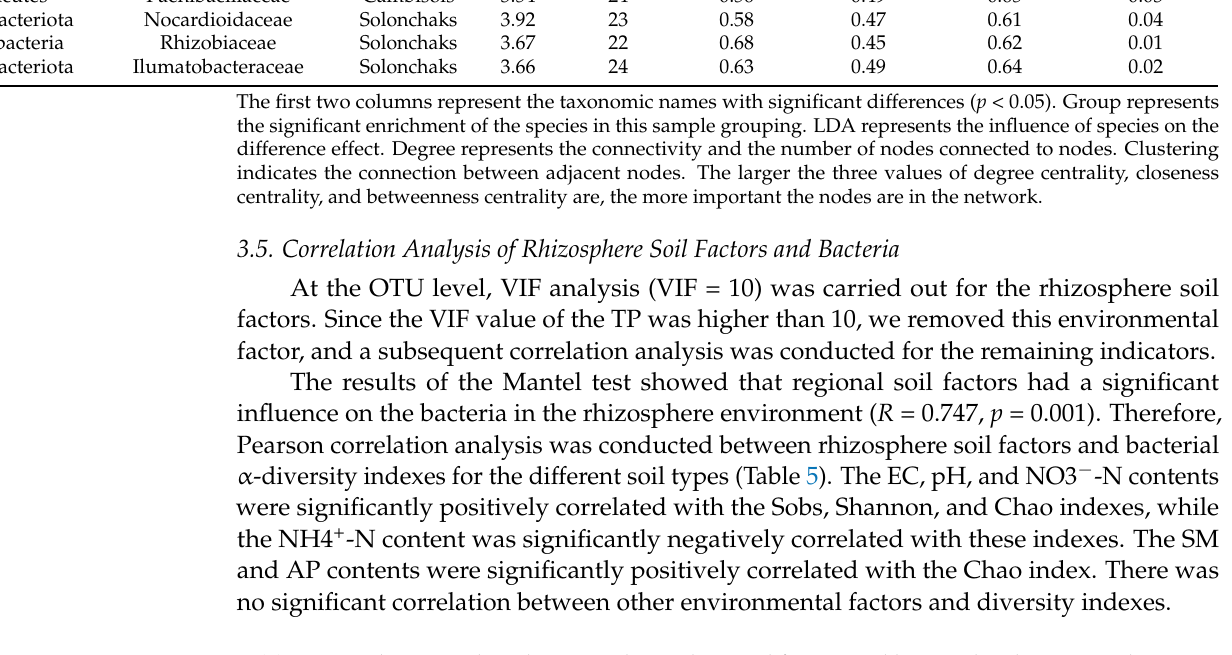
Table 5. Correlation analysis between rhizosphere soil factors and bacterial α -diversity